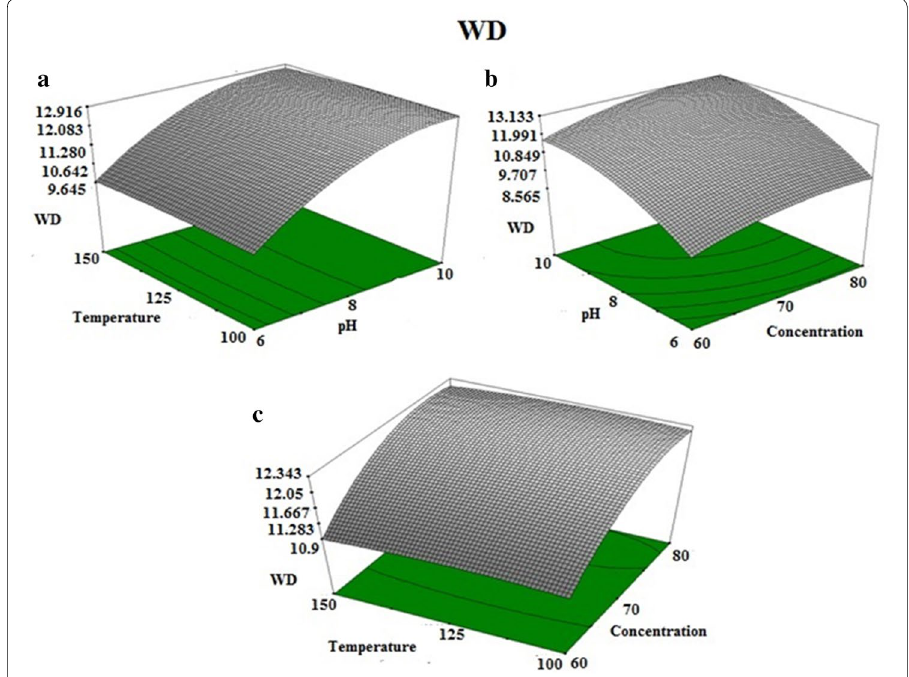
Fig. 6 Effect of a pH and temperature, b pH and concentration, c temperature and concentration on